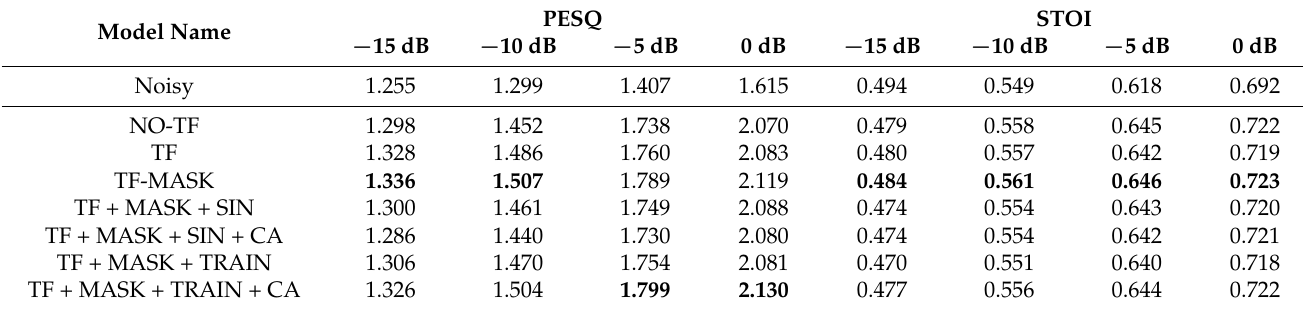
Table 9. Ablation experiments in the VCTK test